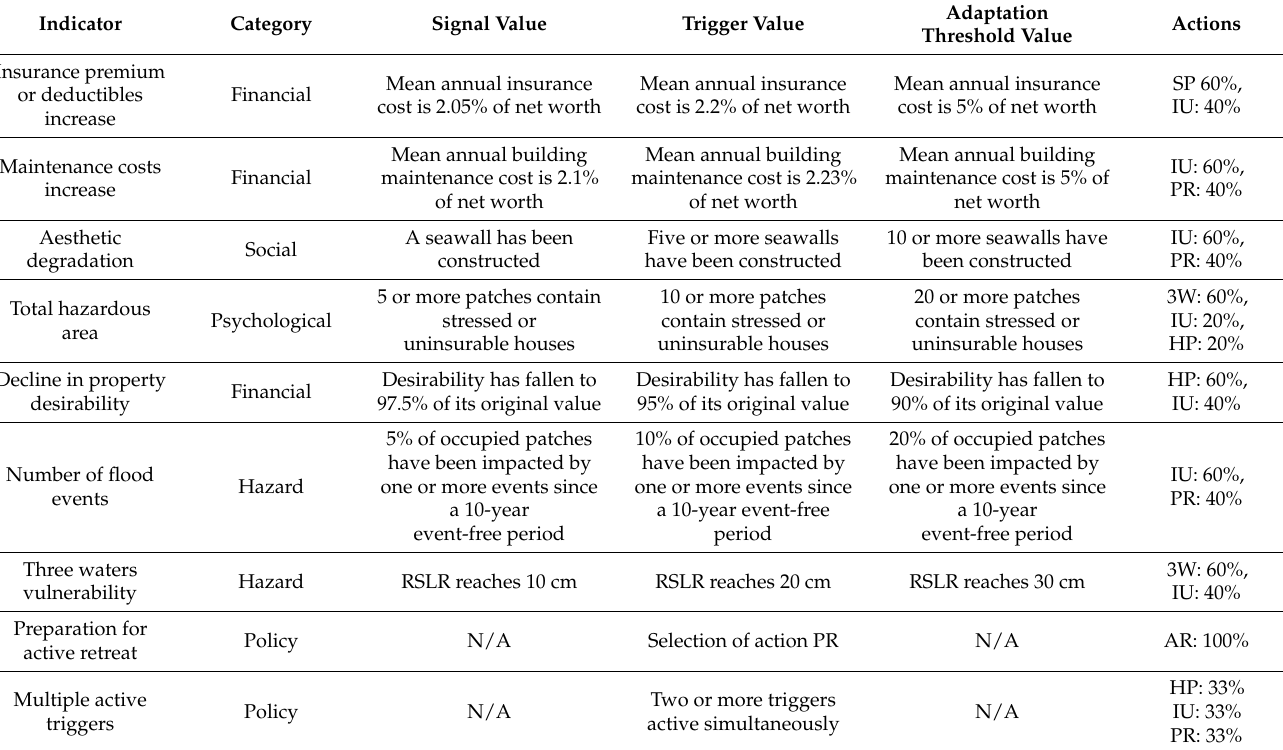
Table 1. Indicators used in MHCABM with the category of indicator they fall into, the signal, trigger and adaptation threshold values, and associated suite of triggered actions. Actions are as follows—SP: soft protection, HP: hard protection, IU: infrastructure upgrades, 3W: three waters 2 upgrade, PR: preparation for active retreat, AR: active